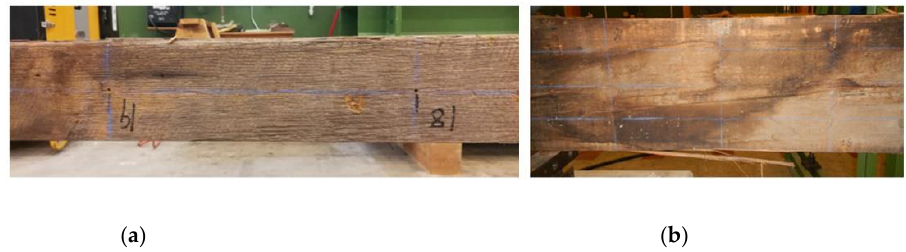
Figure 3. The ground-penetrating radar (GPR) scan lines of the timbers. ( a )The middle scan line on B